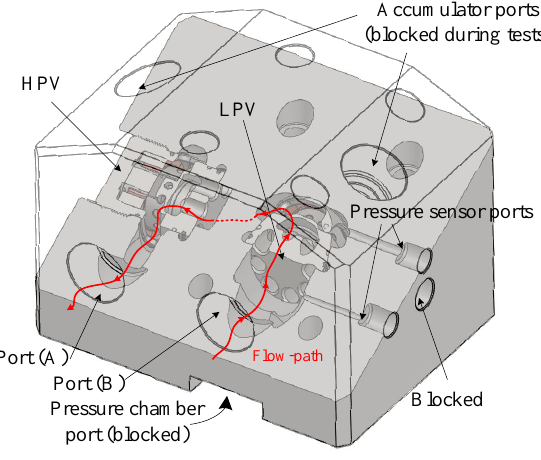
Figure 12: Measured pressure drop across the valve as a function of flow with different plunger po- sitions and oil temperatures.